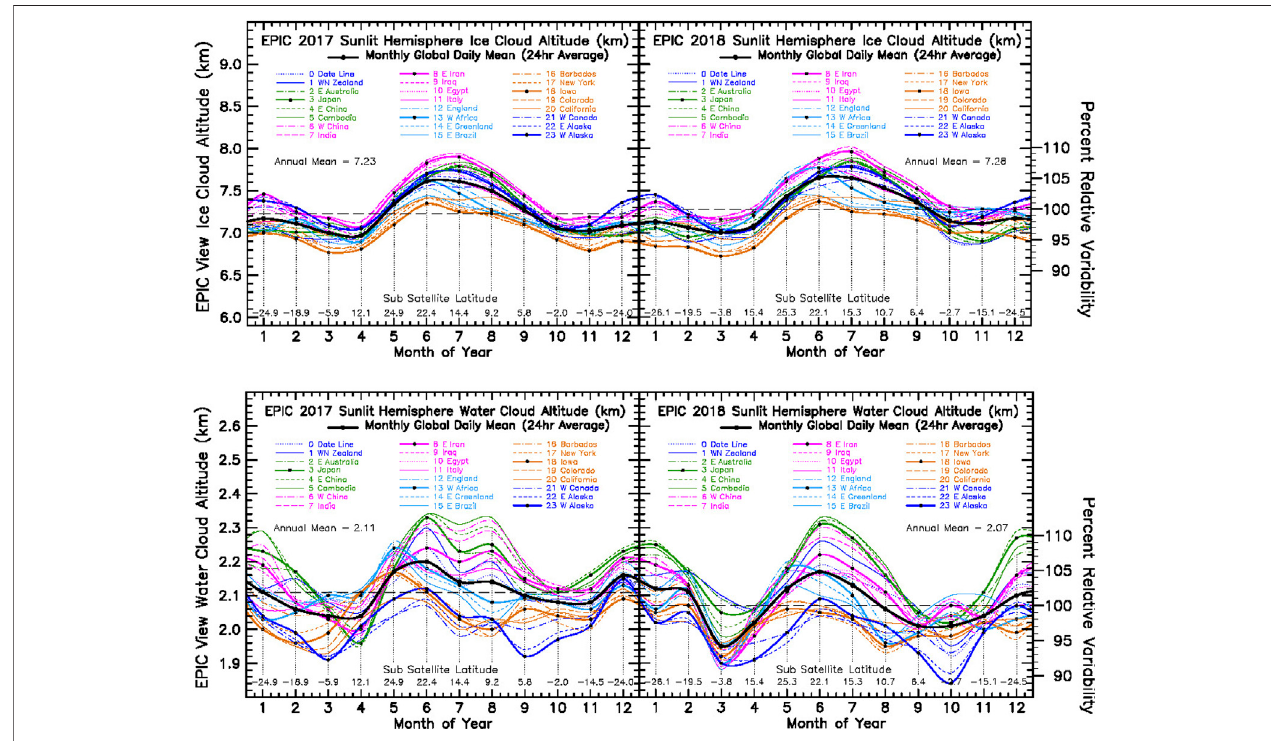
FIGURE 11 | Top Left : Ice cloud altitude from EPIC Composite analysis results for the year 2017, and Top Right : ice cloud altitude for the year 2018. Bottom Panel Left : Water cloud altitude from EPIC Composite analysis results for the year 2017, and Bottom Right : water cloud altitude for 2018.